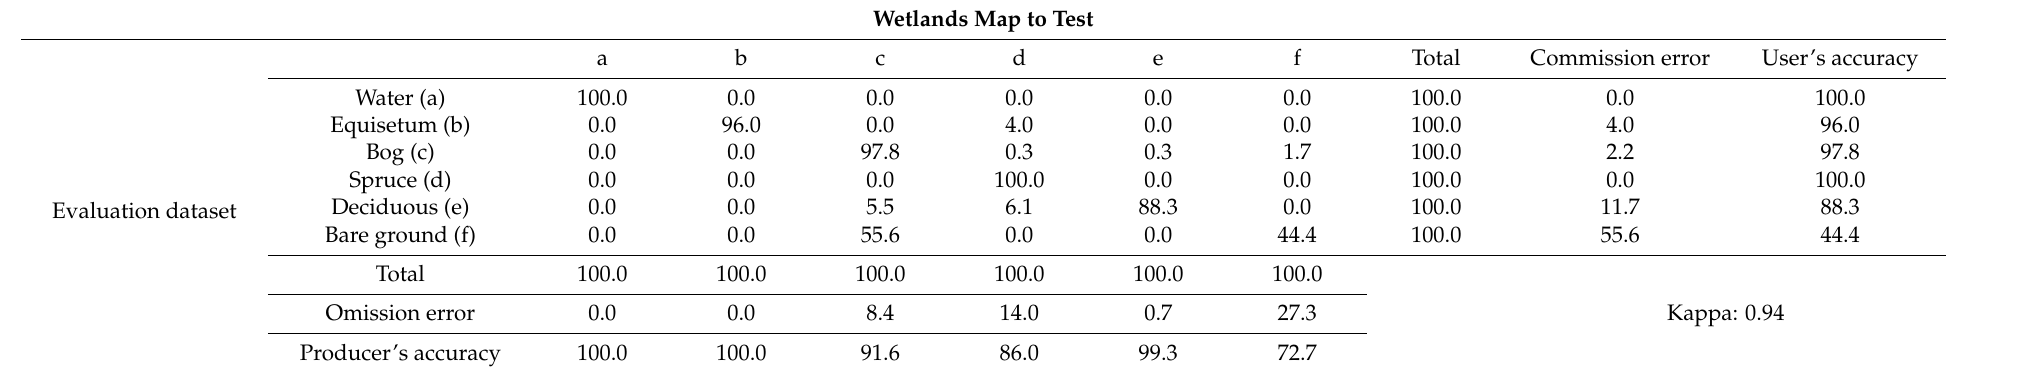
Table 3. Confusion matrix for area A maximum likelihood classification. Results in %.